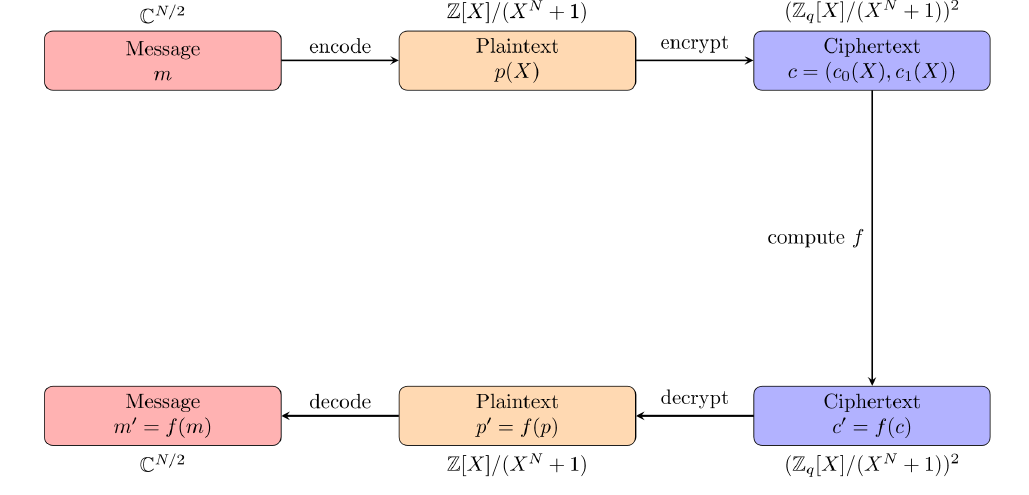
Fig. 5. Overview of CKKS Scheme. 59